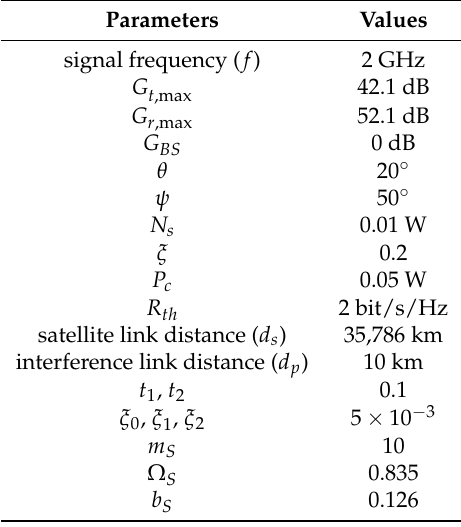
Table 1. Simulation